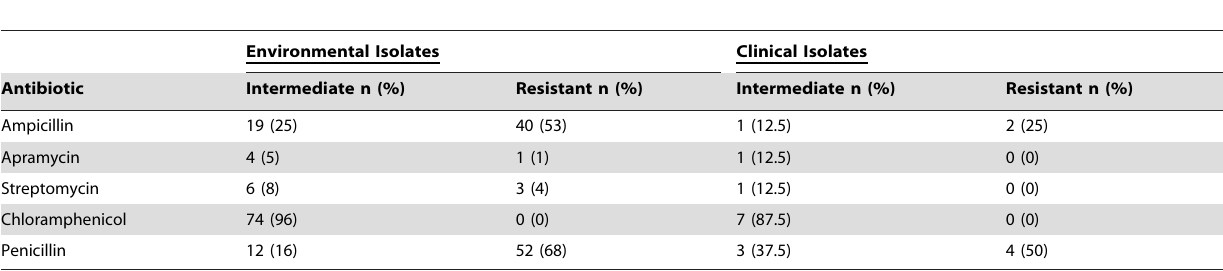
Table 5. Comparison of environmental and clinical V. parahaemolyticus isolates with regard to all antibiotics to which clinical isolates were found to have intermediate resistance or resistance.